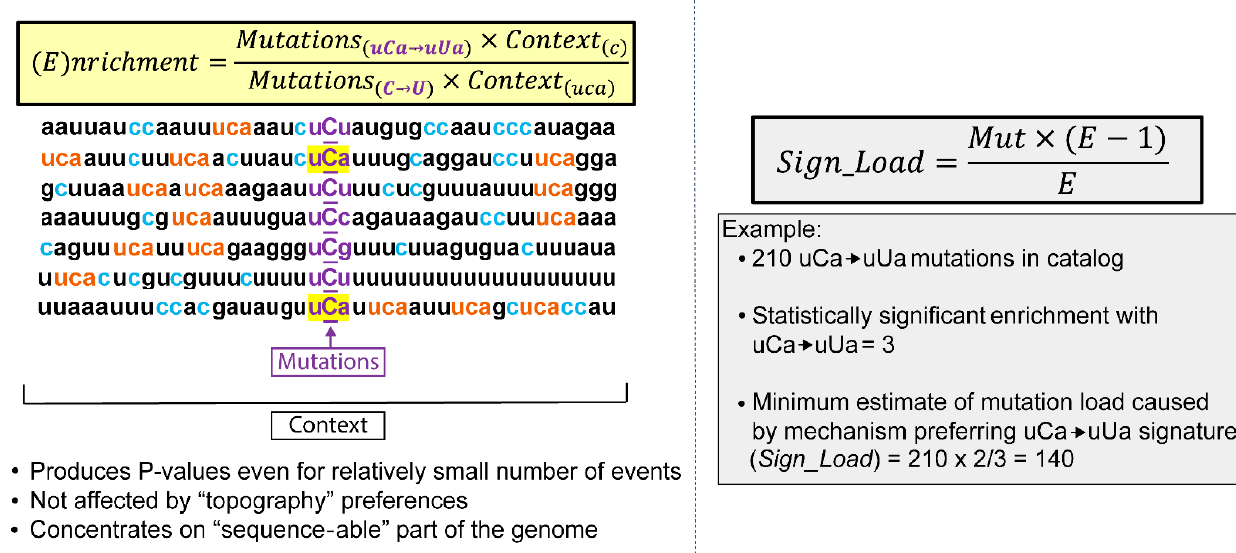
Figure 5. Trinucleotide motif-centered RNA mutational signature analysis. Shown is an example of an analysis for calculating the enrichment (E) and signature-associated mutation load ( Sign Load ) of uCa → uUa signature motifs in ssRNA, which are the two main outputs of trinucleotide motif-centered mutational signature analysis. Reverse complements are not included. Counted are all C → U mutations as well as all trinucleotide motif uCa → uUa mutations (5 (cid:48) and 3 (cid:48) flanking nucleotides shown in small letters; mutated C shown in capital letters). Also counted are all cytosines (c), represented in blue, and all motif-conforming trinucleotides (uca), represented in orange, in 41 nucleotide contexts centered around mutated cytosines. (E) values show the fold-difference between actual fraction of uCa → uUa mutations among C → U mutations in all trinucleotide motifs and the fraction of motif conforming trinucleotides (uca) among all cytosines (c) in the immediate vicinity of mutated cytosines. Counts used for enrichment calculation can be also used for calculating p -values in order to identify trinucleotide mutational motifs with statistically significant enrichment. Statistically significant enrichment values can be used for minimum estimates of a ( Sign Load